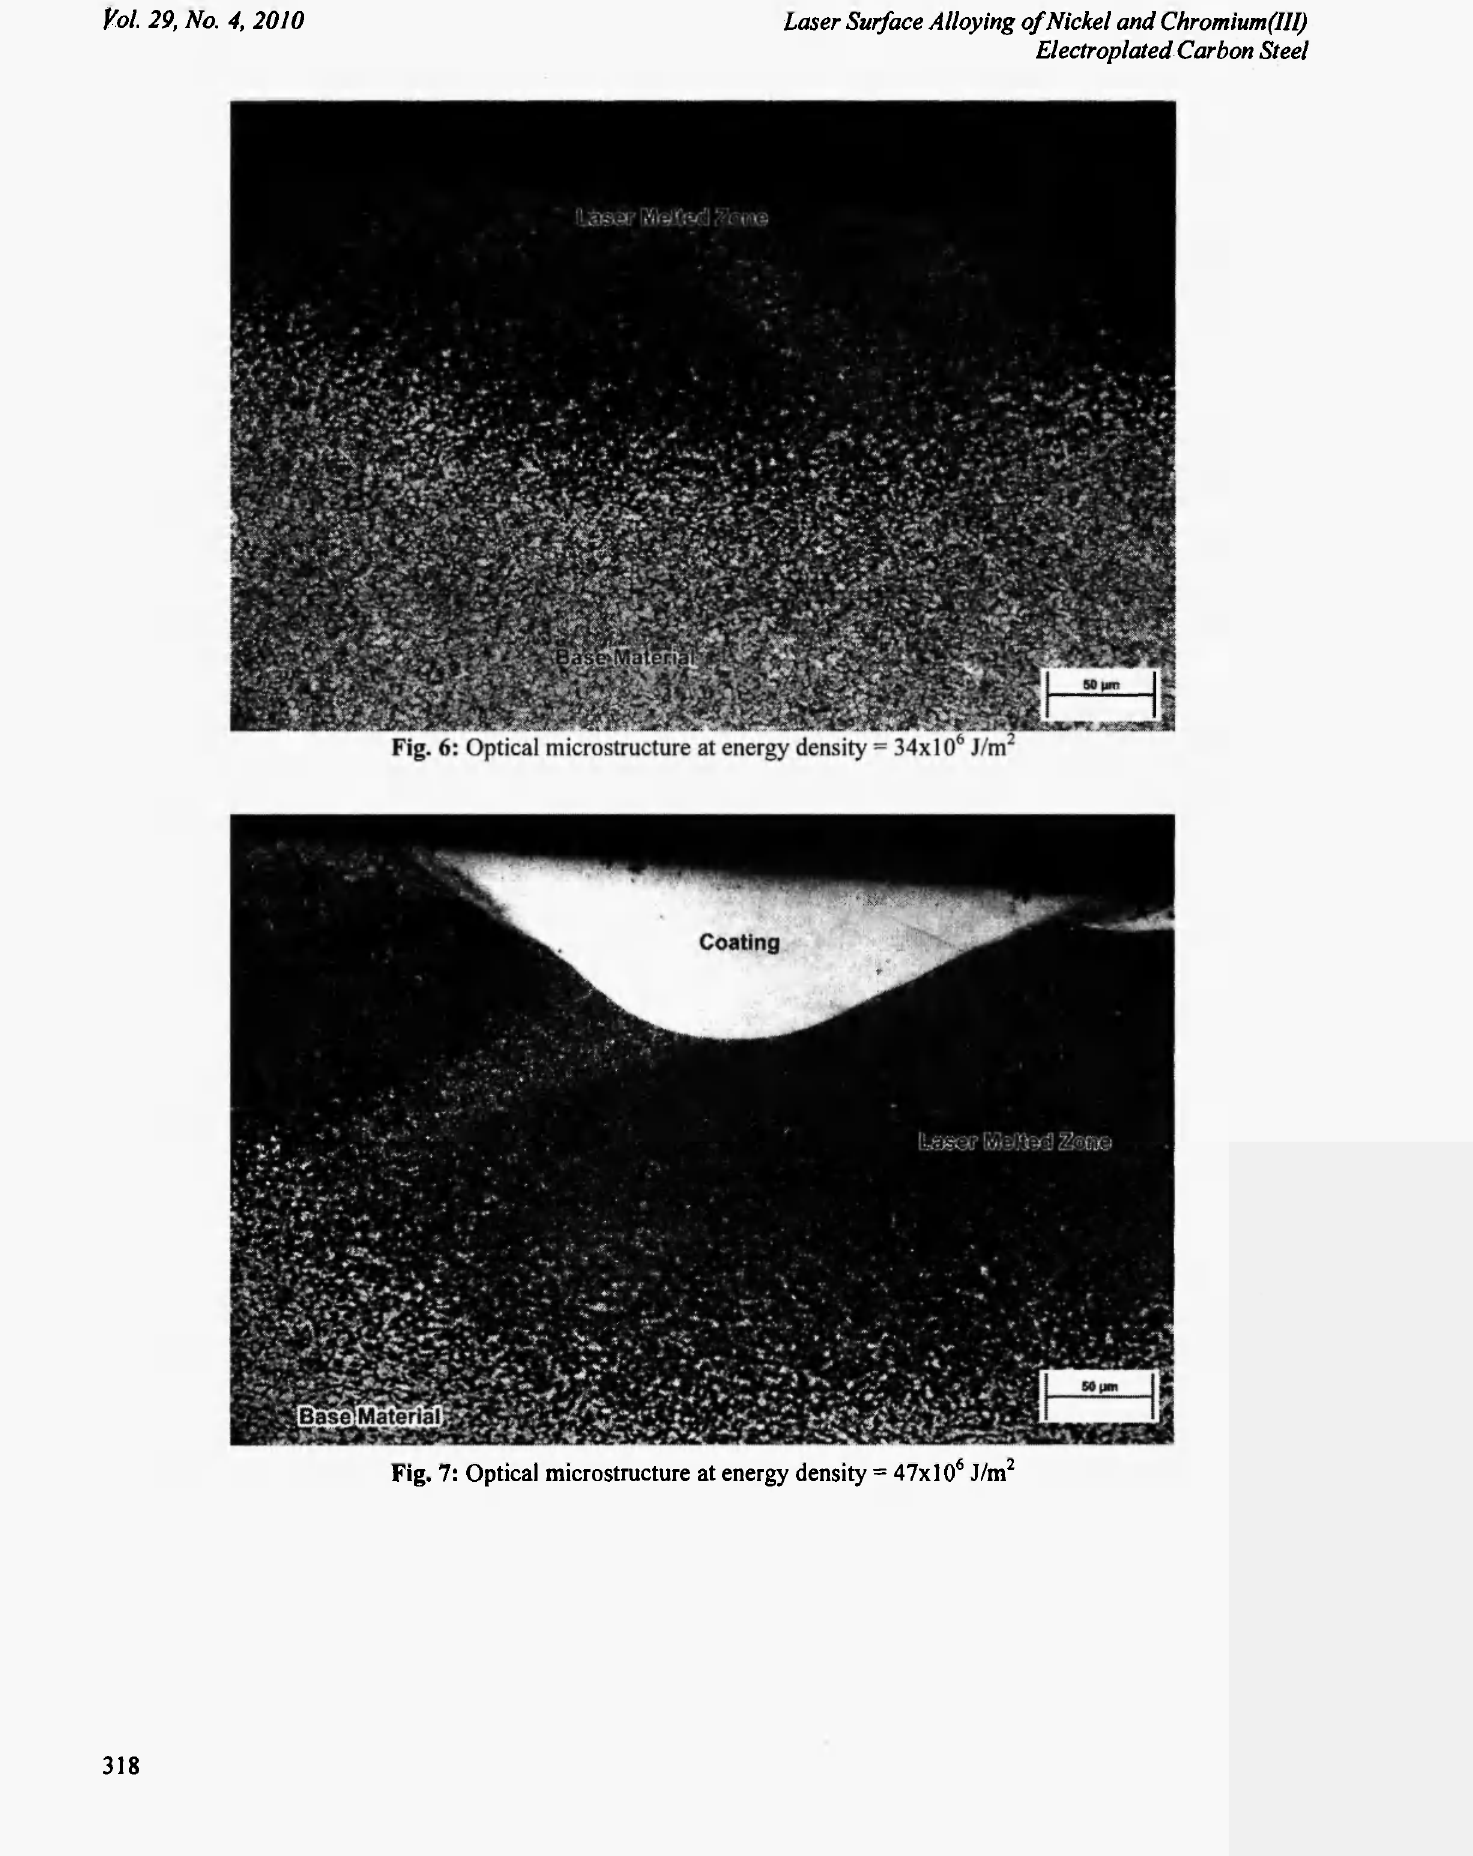
Fig. 7: Optical microstructure at energy density = 47x10 6 J/m 2